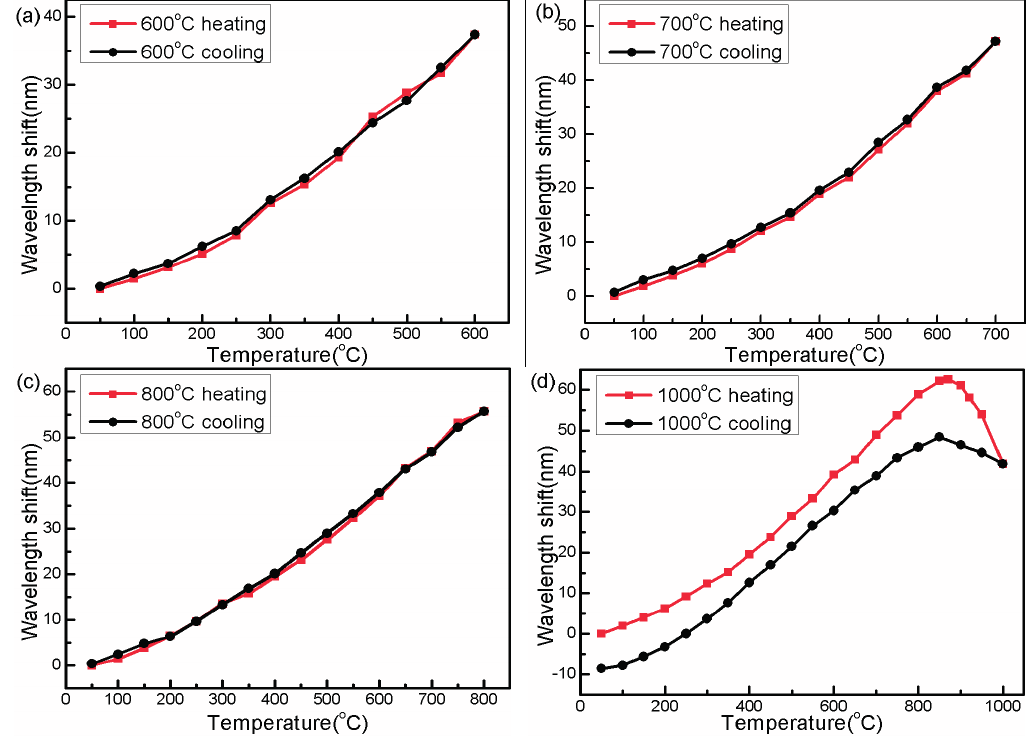
Figure 8. Interference dip wavelength versus the temperature during the different